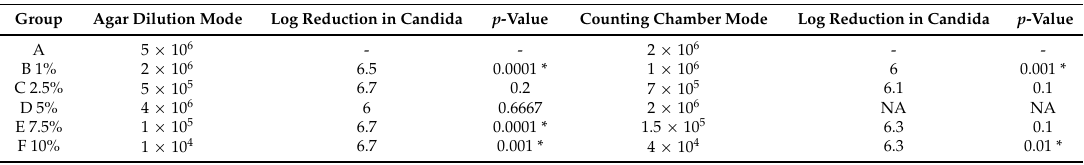
Table 1. Effect of different concentrations of henna on Candida albicans .